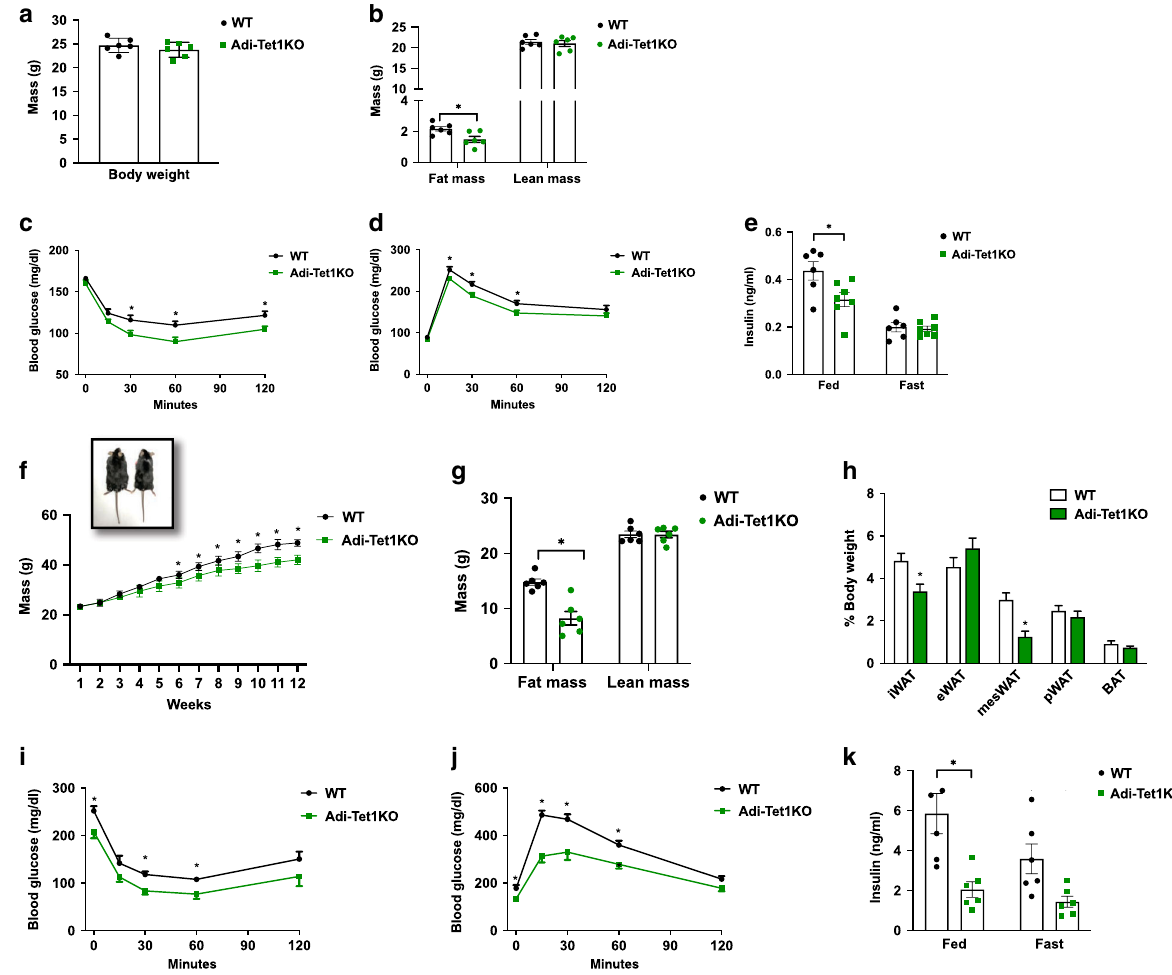
Fig. 5 Adipose-speci fi c Tet1 -KO mice are protected from diet-induced obesity and metabolic dysregulation. a , b Body weight ( a ) and body